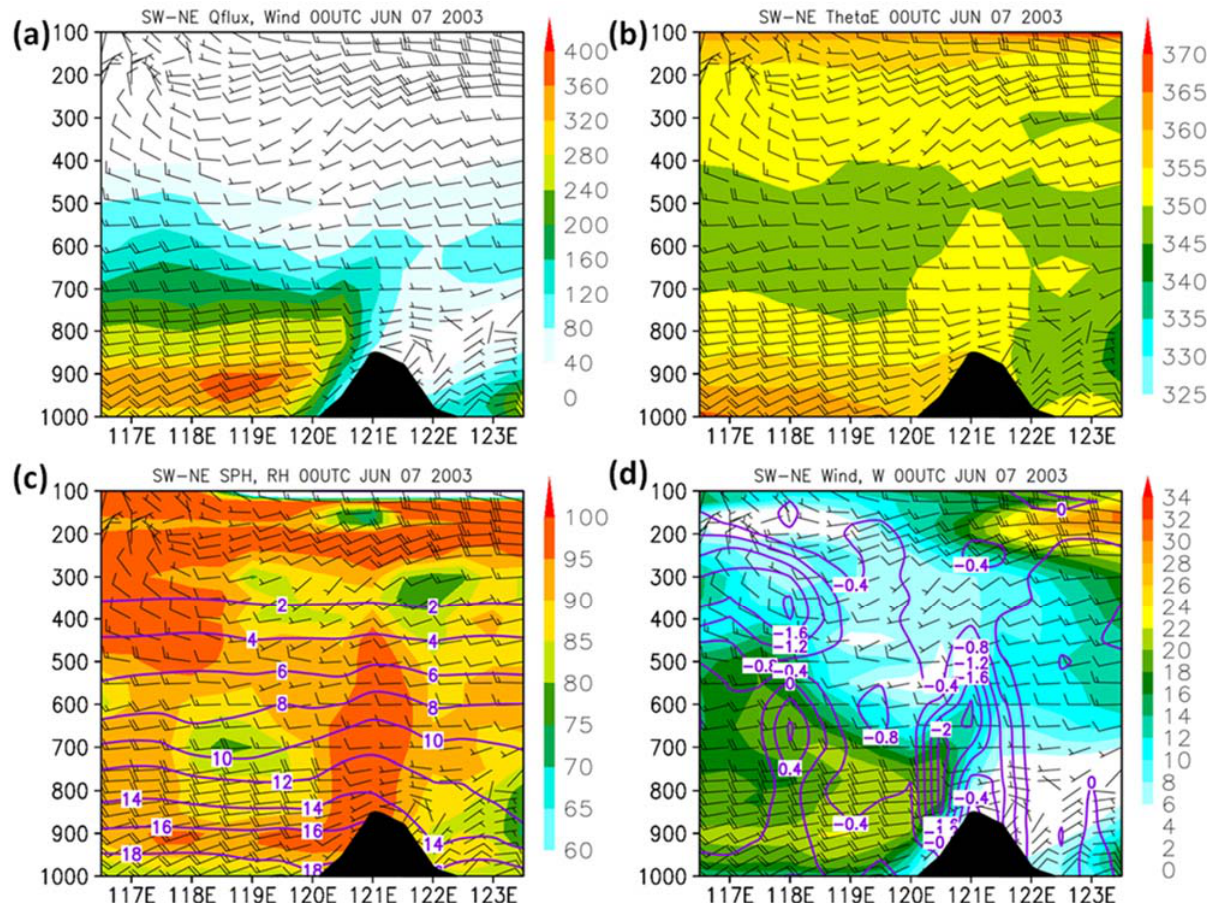
Figure 13. The CFSR vertical cross-section along the NE–SW line (red line in Figure 1) at 0000 UTC (0800 LT) 7 June 2003. ( a ) horizontal moisture flux (qV; g kg − 1 m s − 1 , shaded) and winds ( V ; m s − 1 ) (full barb and half barb represent 10 and 5 m s − 1 , respectively); ( b ) equivalent potential temperature (K, shaded) and winds ( V ; m s − 1 ); ( c ) specific humidity (g kg − 1 , contoured), relative humidity (%, shaded), and winds ( V ; m s − 1 ); ( d ) winds ( V ; m s − 1 ) and vertical motion (Pa s − 1 , contoured).